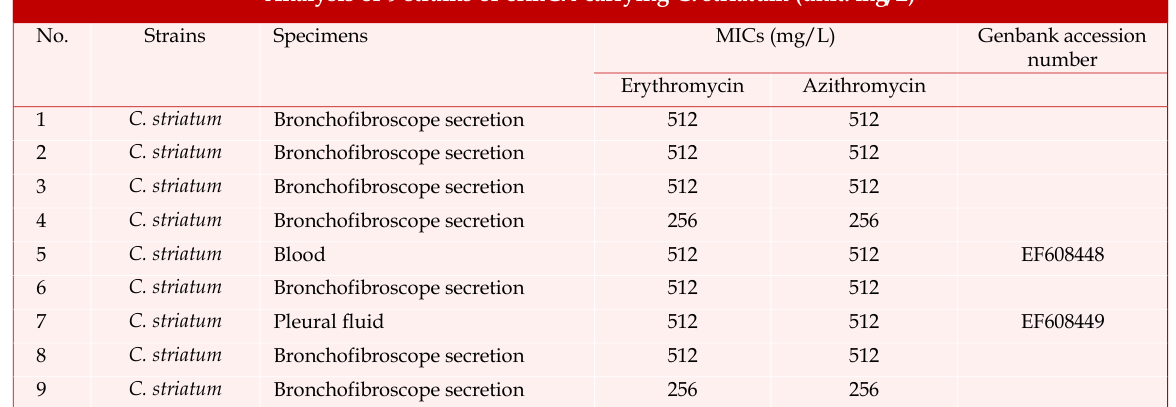
Analysis of 9 strains of ermCX-carrying C. striatum (unit: mg/L)